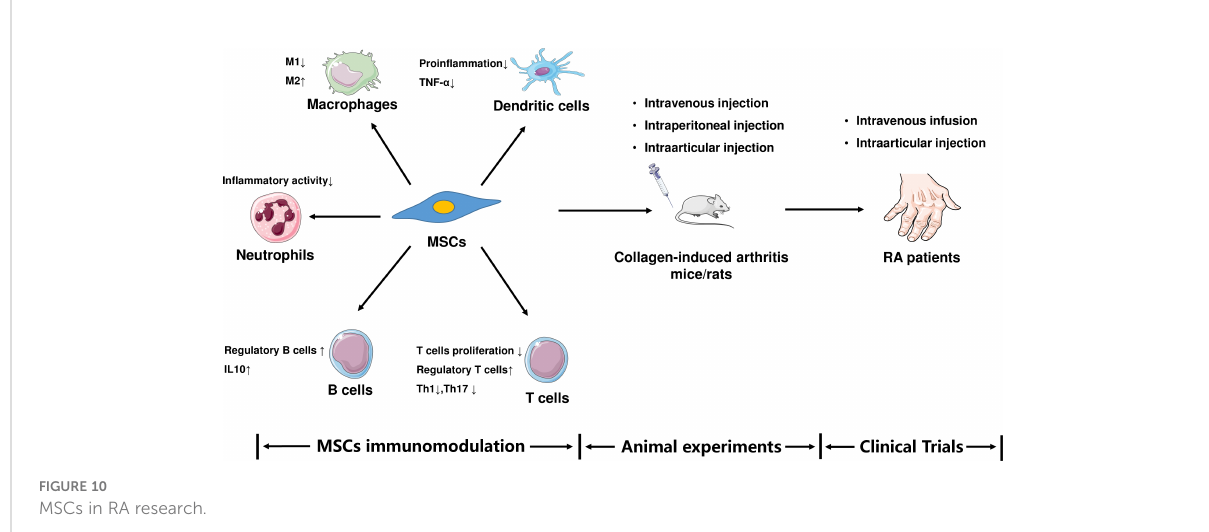
FIGURE 10 MSCs in RA research.